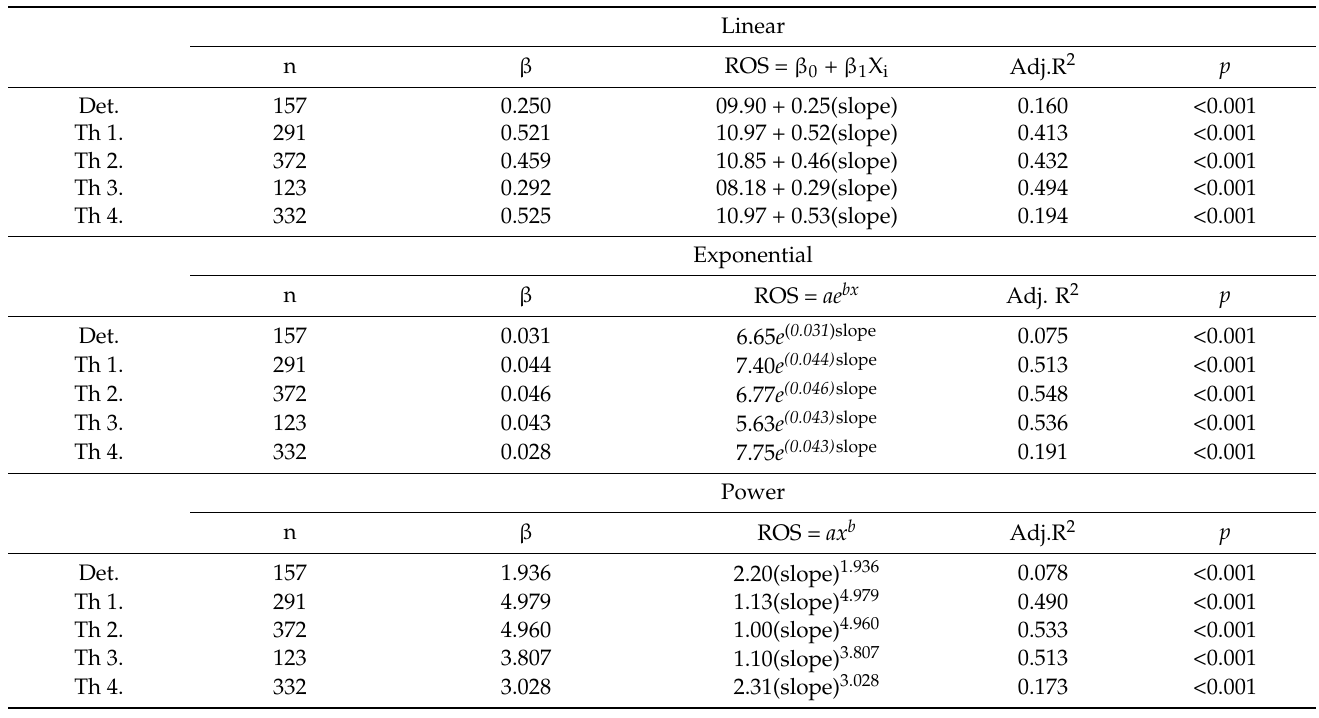
Table 4. Linear, exponential (semi-log), and power (log-log) regression results and model equations for directional slope. Model diagnostics separated by fire and airborne thermal infrared image sequence.